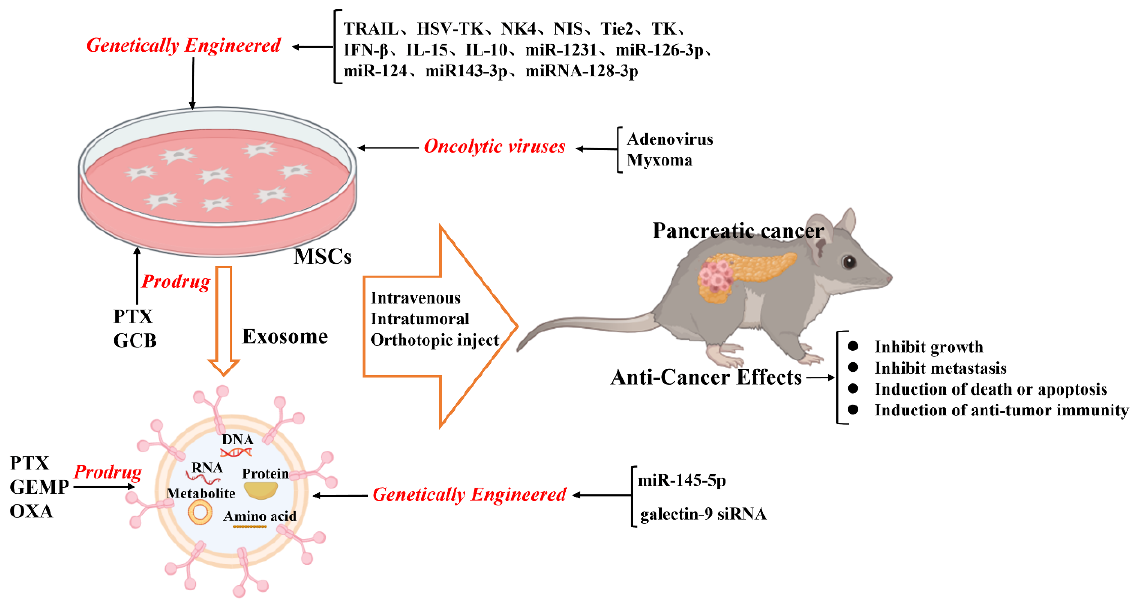
Figure 1. Schematic illustration of the current anticancer treatment based on mesenchymal stromal cells (MSCs) and MSC-derived exosomes.